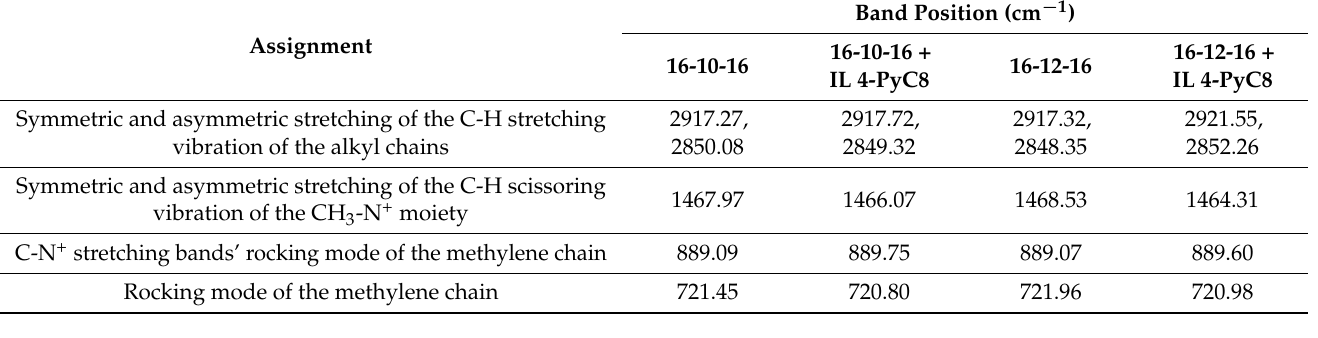
Table 5. Infrared transmittance band and different modes of vibration of the gemini surfactants, 4-PyC8, and their mixtures.